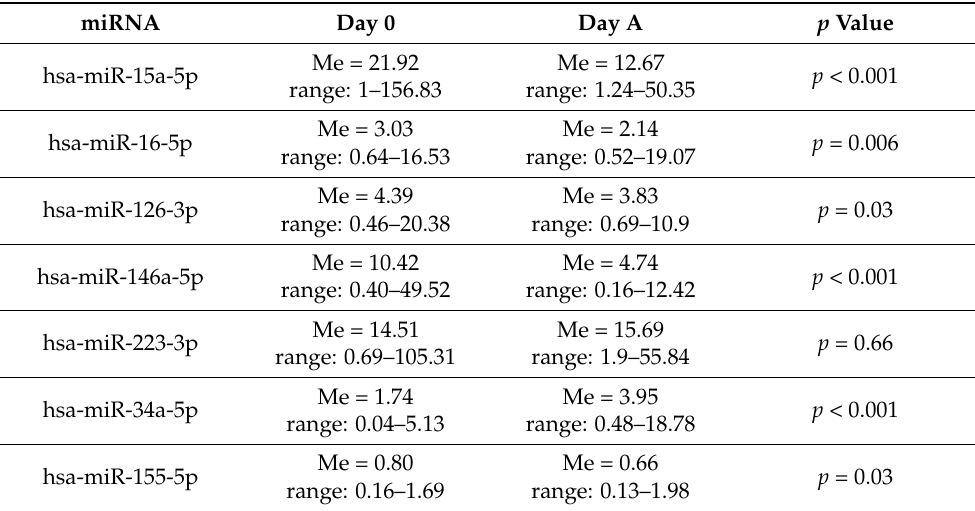
Table 3. Changes in miRNA expression (RQ) before mobilization chemotherapy and on the day of the first